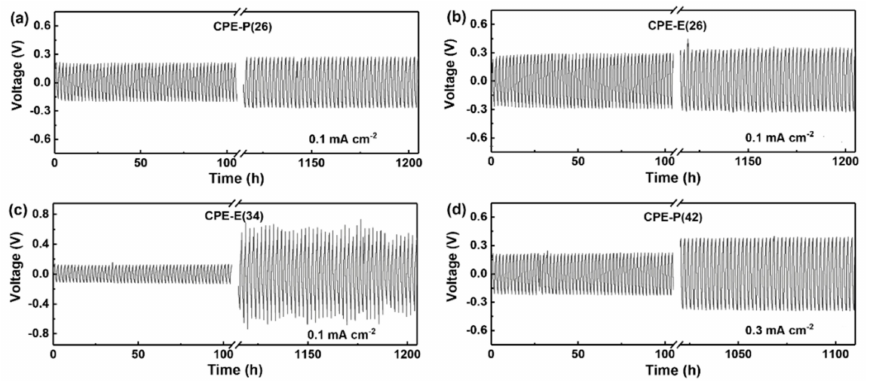
Figure 6. Voltage profiles of lithium symmetric cells for CPE-P(26) ( a ), CPE-E(26) ( b ), and CPE-E(34) ( c ) at 0.1 mA cm − 2 and CPE-P(42) at 0.3 mA cm − 2 ( d ) at 60 ◦ C.